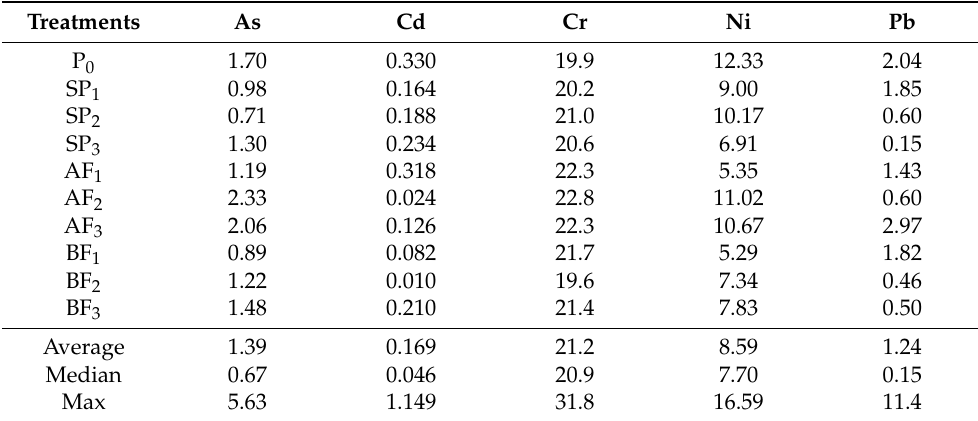
Table 7. Soil content of potentially toxic elements (PTE) after spring wheat (2016) harvest, mg kg –1 of soil DM 1